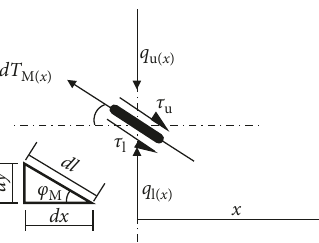
Figure 7: Mechanical analysis of a deflected element of the geosynthetic. horizontal direction; and y deflection of the geosynthetic and its derivative form at point M with an abscissa position x to the midpoint.